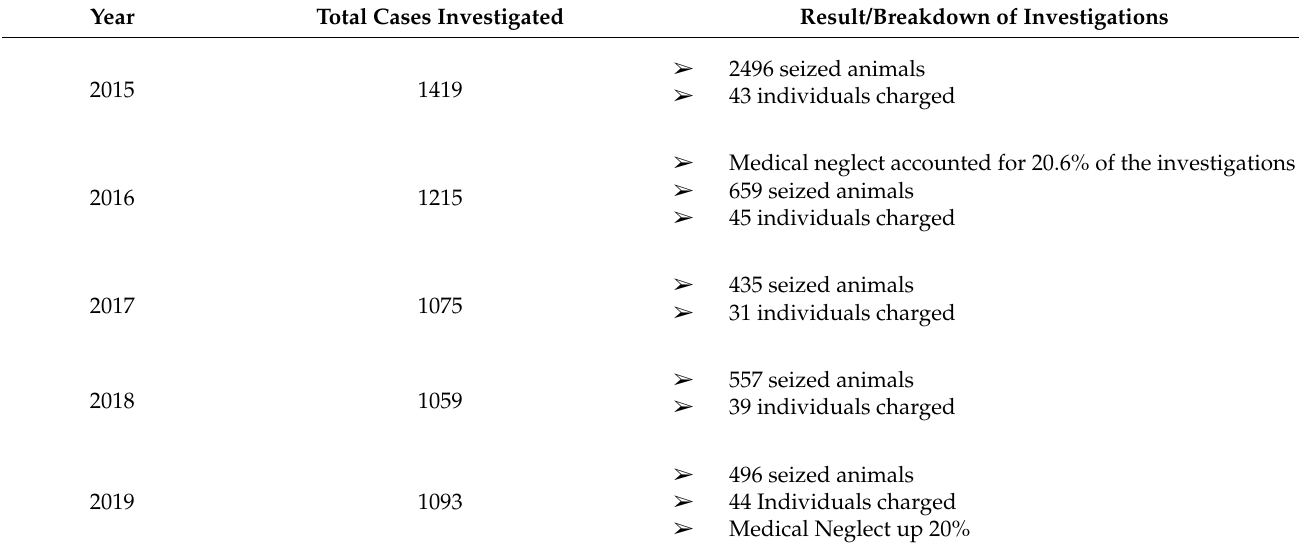
Table 7. Investigations Details from Calgary. Data provided by the Calgary Humane